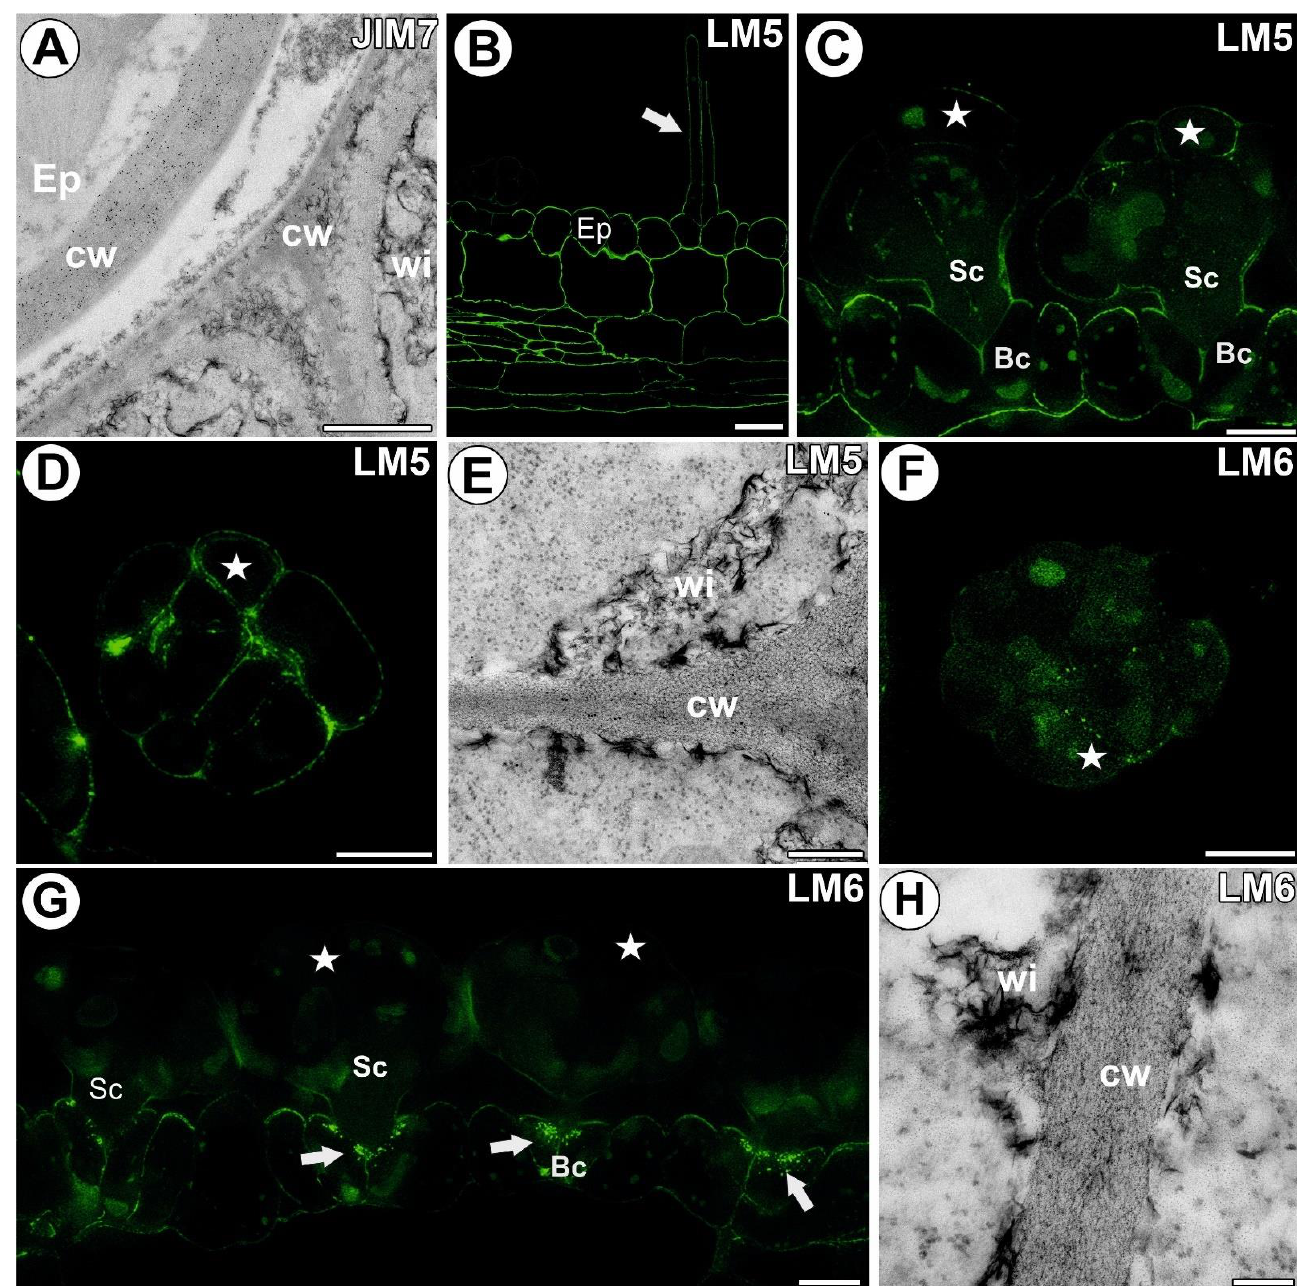
Figure 4. Homogalacturonans detected in the A. vesiculosa trap. ( A ) Immunogold labeling of the cell wall with JIM19 in the ordinary epidermal (Ep) and glandular cells; wall ingrowths (wi), cell wall (cw); bar 900 nm. ( B ) HG (labeled with LM5) detected in the trap wall; epidermal cell (Ep), sensory trichome (white arrow), bar 10 µm. ( C ) HG (labeled with LM5) detected in the glands; secretory cell (star), stalk cell (Sc), basal cell (Bc), bar 10 µm. ( D ) HG (labeled with LM5) detected in the gland, paradermal section; secretory cell (star), bar 10 µm. ( E ) Immunogold labeling of the wall ingrowths with LM5 in the glandular cells; wall ingrowths (wi), cell wall (cw); bar 300 nm. ( F ) HG (labeled with LM6) detected in the gland, transverse section; secretory cell (star), bar 10 µm. ( G ) HG (labeled with LM6) detected in the glands and trap wall; secretory cell (star), stalk cell (Sc), basal cell (Bc), wall labyrinth in the basal cell (white arrow), bar 10 µm. ( H ) Immunogold labeling of the wall ingrowths with LM6 in the glandular cells; wall ingrowths (wi), cell wall (cw); bar 100 nm.